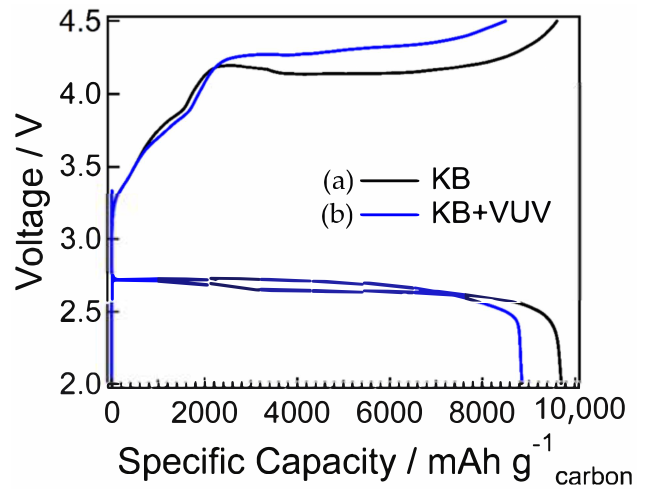
Figure 5. Full discharge and charge curves of Li-air batteries using (a) KB and (b) KB + VUV as cathodes.